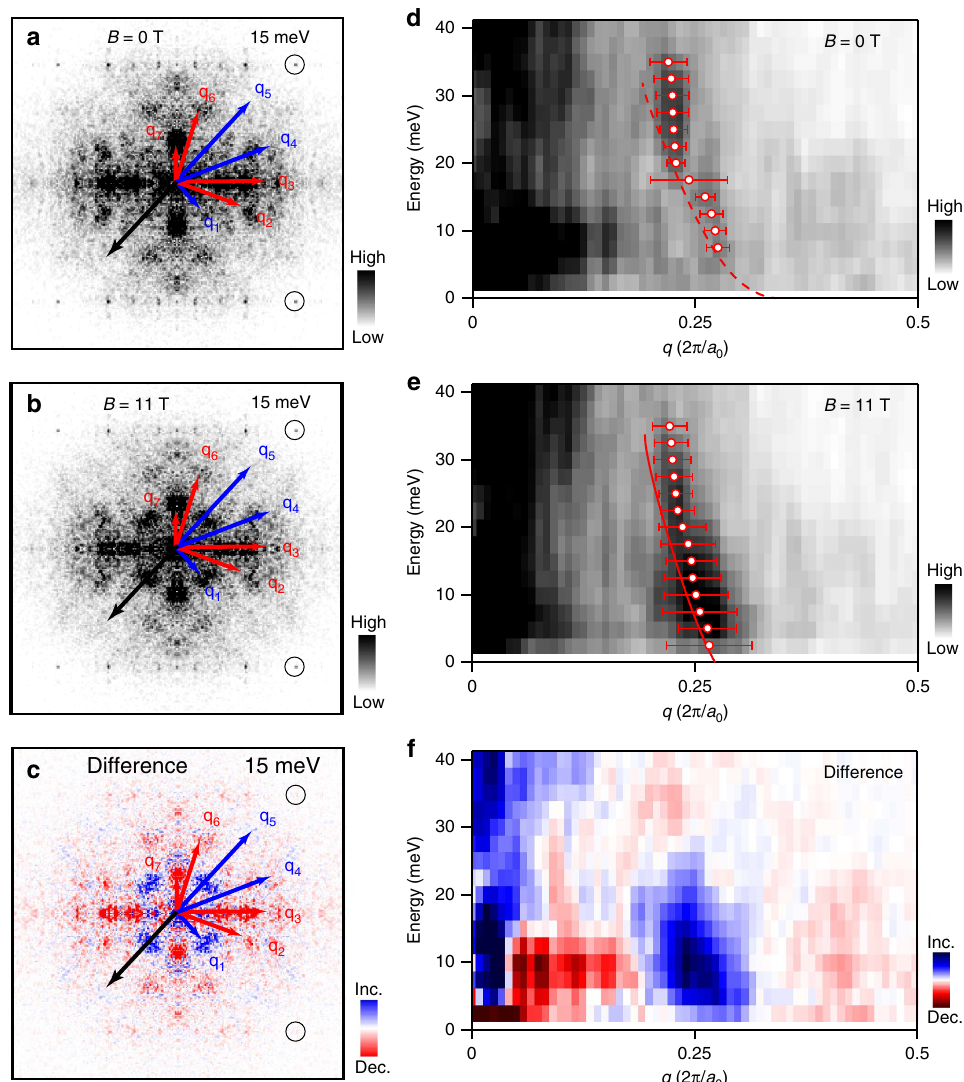
Figure 2 | Bogoliubov quasiparticle interference origin of the vortex checkerboard. ( a , b ) Conductance-ratio maps in scattering-vector q space Z q ( q , E , B ) at energy E ¼ 15meV in magnetic fields B ¼ 0 and 11T, respectively. Each map was obtained by the Fourier transformation of the real-space conductance-ratio map taken with the field of view of 470 (cid:5) 470Å 2 , followed by the twofold symmetrization. The tunnelling conductance at each location was taken by the standard lock-in technique with a modulation amplitude of 2.5mV rms . Red and blue arrows indicate the sign-reversing ( q 2 , q 3 , q 6 , q 7 ) and sign-preserving scattering ( q 1 , q 4 , q 5 ) wavevectors, respectively. Black circles show the Bragg spots. ( c ) Difference between a and b Z q ( q , E ¼ 15meV, B ¼ 11T) (cid:3) Z q ( q , E ¼ 15meV, B ¼ 0T). ( d , e ) Energy-dependent line profiles taken along the black arrows in a and b , respectively. Red open circles denote the position of the q 1 peak that has been determined by fitting the line profile at each energy by a Lorentzian function. Error bars indicate the full width at half maximum of the fitted peak. Dashed red line in d and solid red line in e are the dispersions calculated from q 2 , q 3 , q 6 and q 7 based on the octet model. Note that the B -induced signal exhibits the dispersion that is consistent with the Bogoliubov quasiparticle interference. ( f ) Energy-dependent line profile taken along the black arrow in c , showing the B -induced